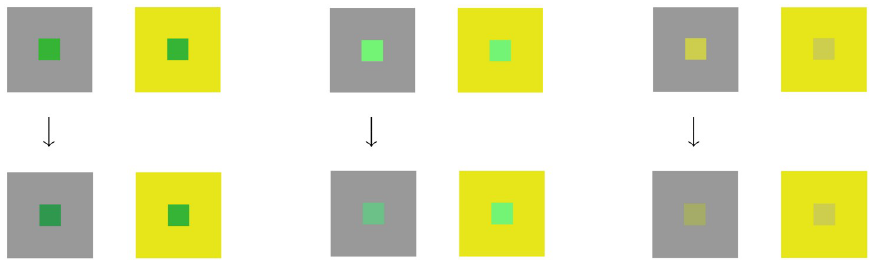
Fig 3. A typical color matching experiment. Upper row, left to right. For each of the three pairs of (gray, yellow) large squares, the central patches have identical colors. Their HSL coordinates are (120˚, 55%, 46%), (120˚, 85%, 71%), (60˚, 57%, 56%), respectively. The HSL color space is extensively used in computer graphics and defined in [21]. Lower row, left to right. One of the authors (A.S.) has modified the HSL coordinates of the left central patch, in order to obtain perceptually equal patches (as much as possible). This is called matching . We can see how far the “perceived” HSL are from reality: (138˚, 55%, 39%), (140˚, 41%, 59%), (66˚, 29%, 54%). The reader probably does not perceive the two patches as perceptually equal, because matching is